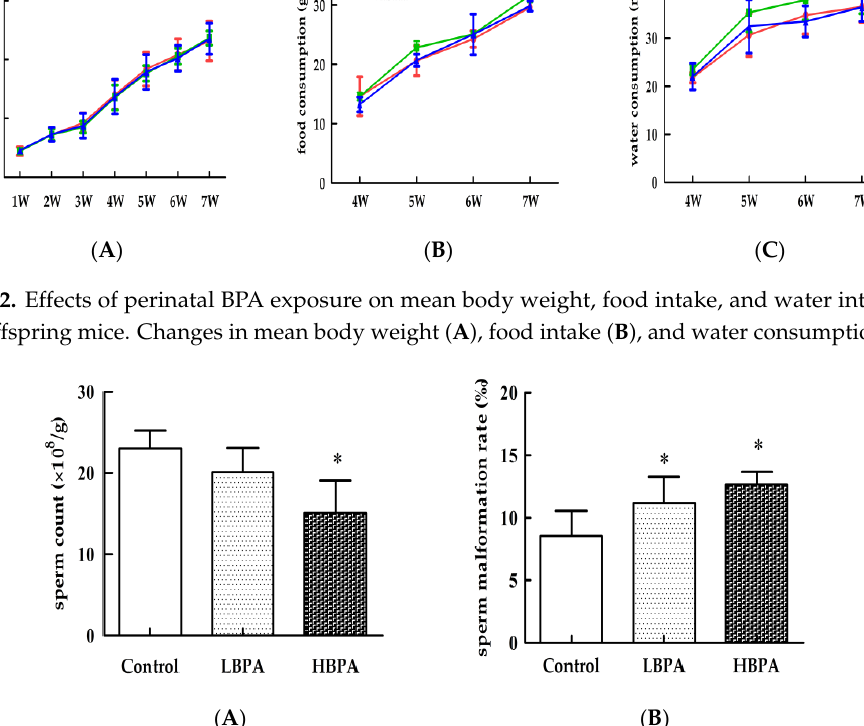
Figure 3. Effects of perinatal BPA exposure on sperm count ( A ) and sperm malformation rate ( B ) in the epididymi of male offspring. Data are reported as means ± SE ( n = 7, one from each group) and were analyzed by one-way ANOVA. * p < 0.05 compared with controls.